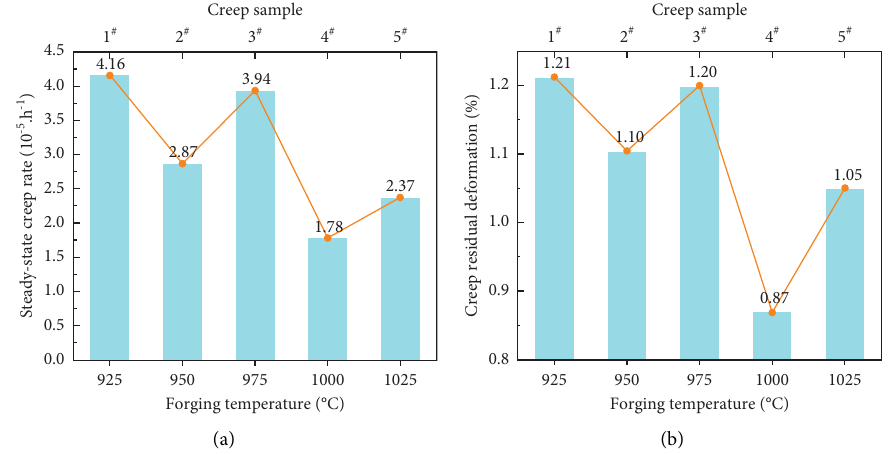
Figure 6: Creep characteristics of Ti-6Al-4V alloy at diferent forging temperatures: (a) steady-state creep rate; (b) creep residual deformation. Table 3: Creep equation and parameters of Ti-6Al-4V alloy at diferent forging temperatures. Samples